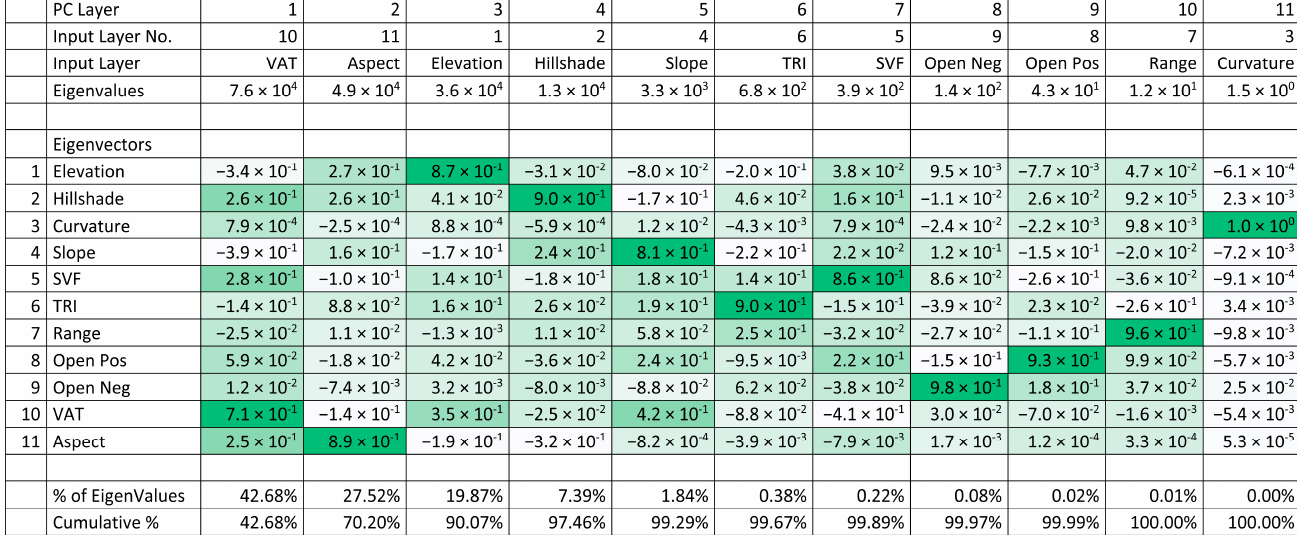
Figure 11. Eigenvalues and eigenvectors of the input layers. The intensity of the color indicates a higher ratio of eigenvalues.